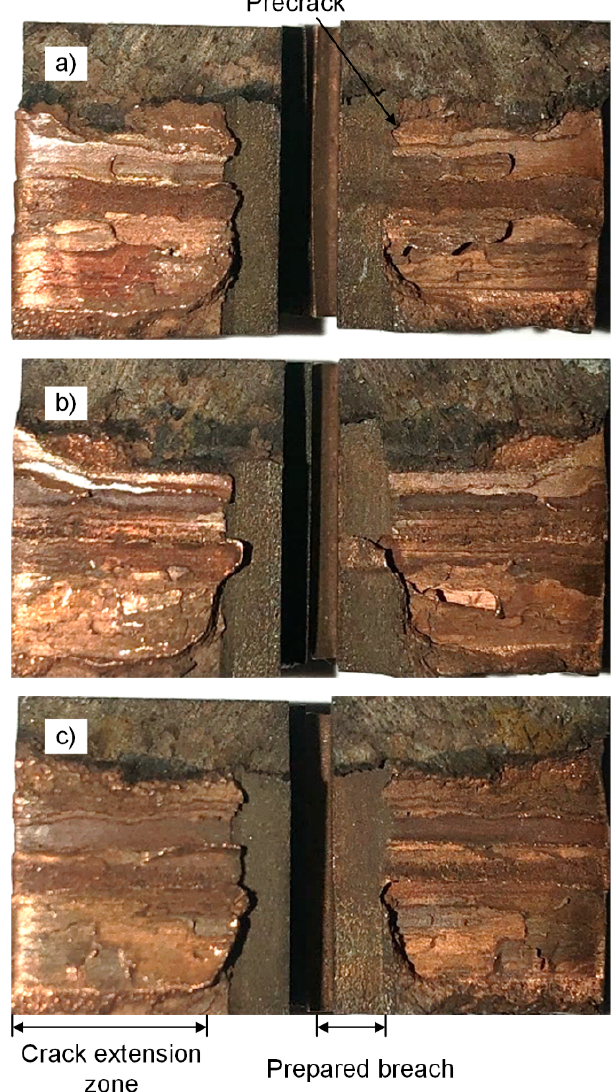
Figure 10. Macro-morphology fracture surface of three-point bending specimen ( a ) for specimen 1; ( b ) for specimen 2; and ( c ) for specimen 3; steel on the left and copper on the right.